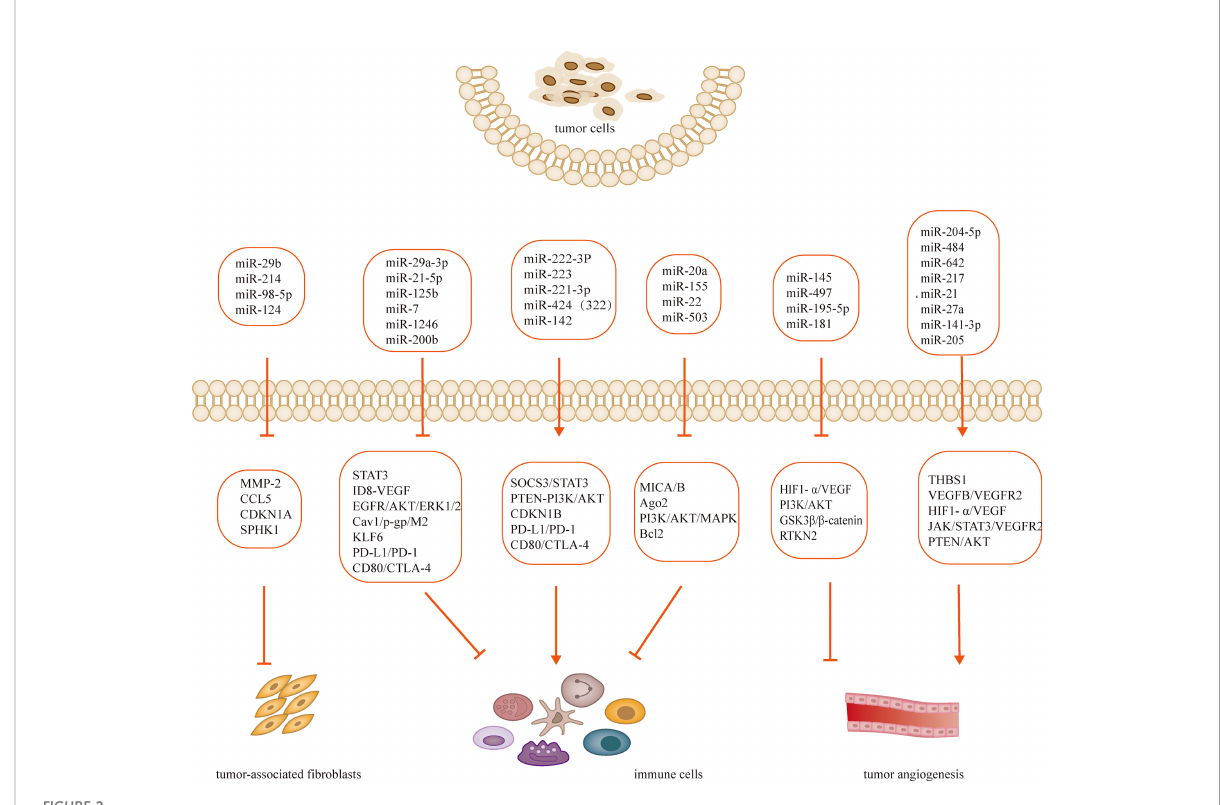
FIGURE 2 MiRNAs regulates TME and participates in the development of ovarian